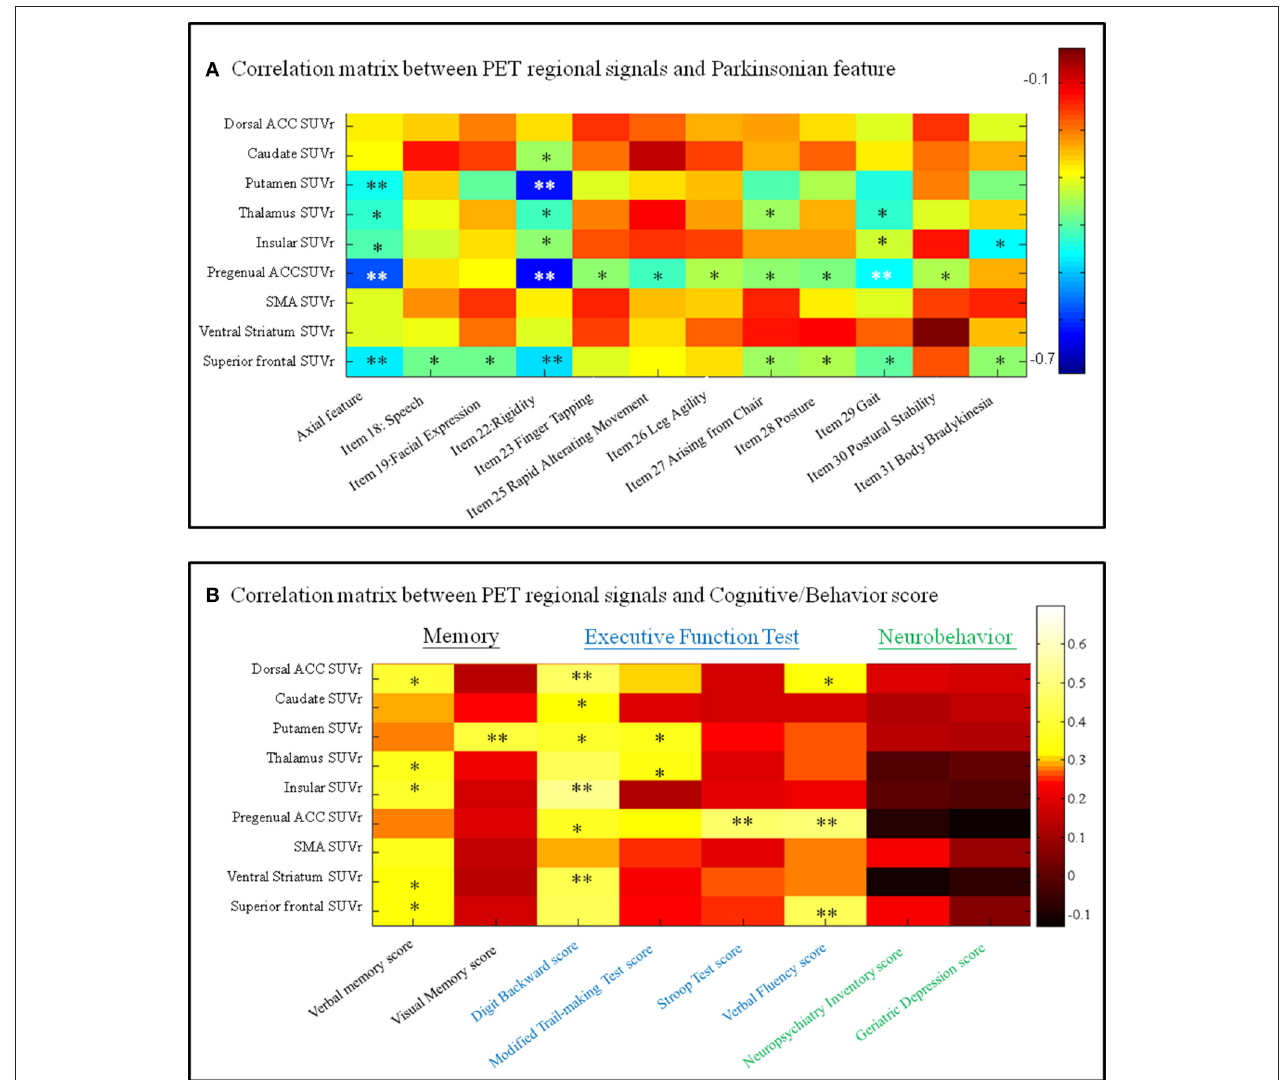
FIGURE 6 | Correlation matrix between regional imaging parameters and (A) Unified Parkinson’s Disease Rating Scale items or (B) cognitive and neurobehavior scores. SUVr, standard uptake value ratio; ACC, anterior cingulate cortex; SMA, supplementary motor area. * p < 0.05, ** p < 0.01. Color bar, Pearson correlation coefficient value. PET, positron emission